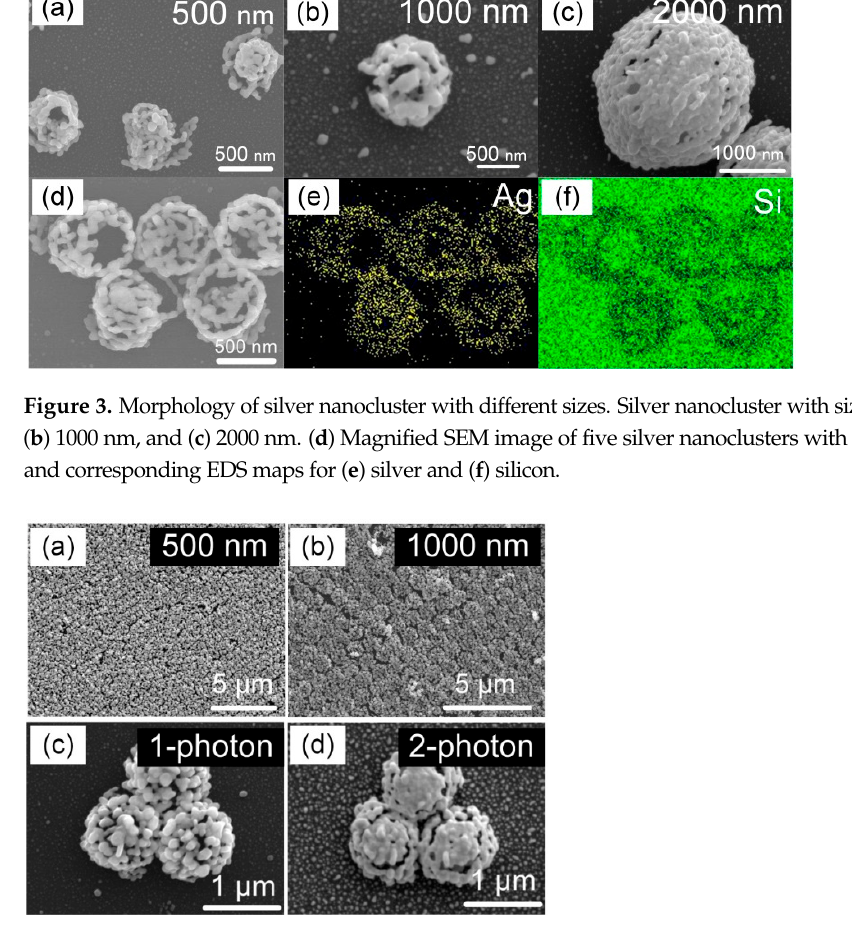
Figure 4. Single-photon absorption and two-photon absorption induced reduction for fabrication of plasmonic hollow nanocluster arrays. Plasmonic hollow nanocluster arrays with periods of ( a ) 500 nm and ( b ) 1000 nm fabricated using a CW laser. High magnification SEM images of 1000 nm period nanoclusters fabricated by laser near-field reduction based on ( c ) single-photon absorption and ( d ) two-photon absorption.